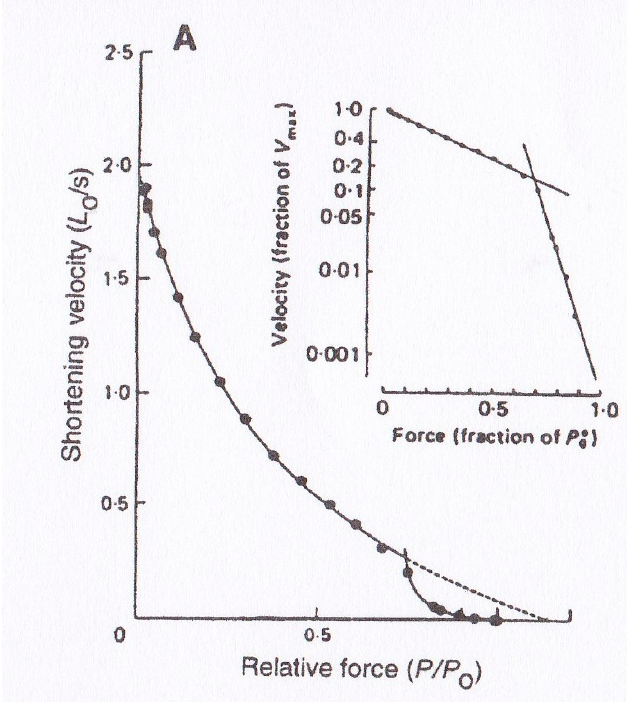
Figure 4. Double-hyperbolic P–V relation obtained from single tetanized intact frog muscle fibers. Inset shows semi-logarithmic plot of the same P–V data points. From [2].